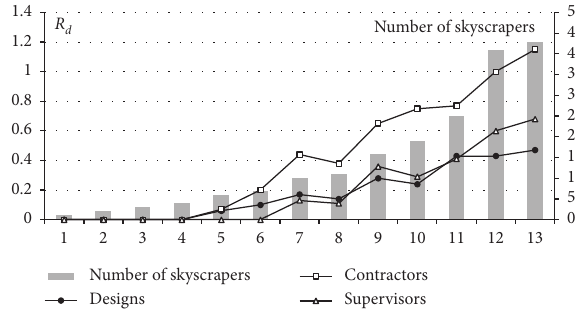
Figure 2: Collaboration index ( R d ) of different types of organi- sations from 1996 to 2015. The left axis represents the R d value, which is the value of the line chart; the right axis represents the number of skyscrapers, which is the value of the bar chart. 1–13 on the horizontal axis represents 1996–2015, of which 1998 and 2001–2005 data are